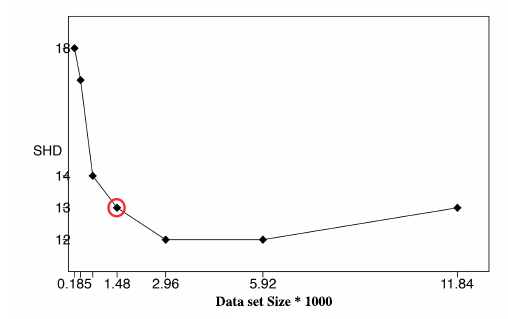
Figure 9. Structural Hamming distance (SHD) of different data set sizes using calculated ALS (Table 3) as reference value (red circle), Alarm